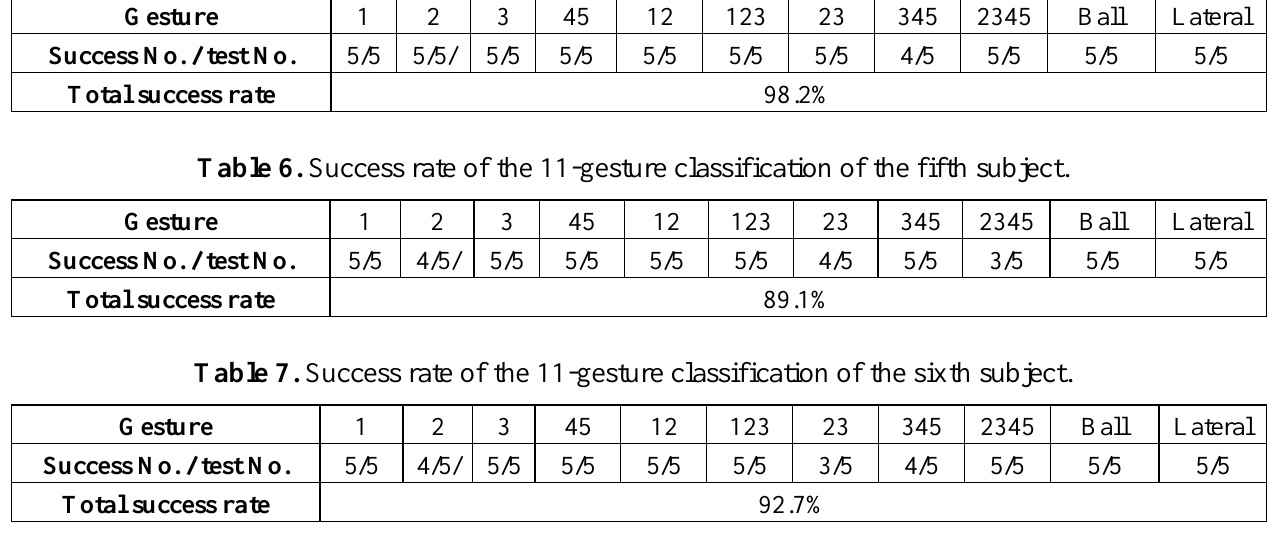
Table 5. Success rate of the 11-gesture classification of the fourth subject. Gesture